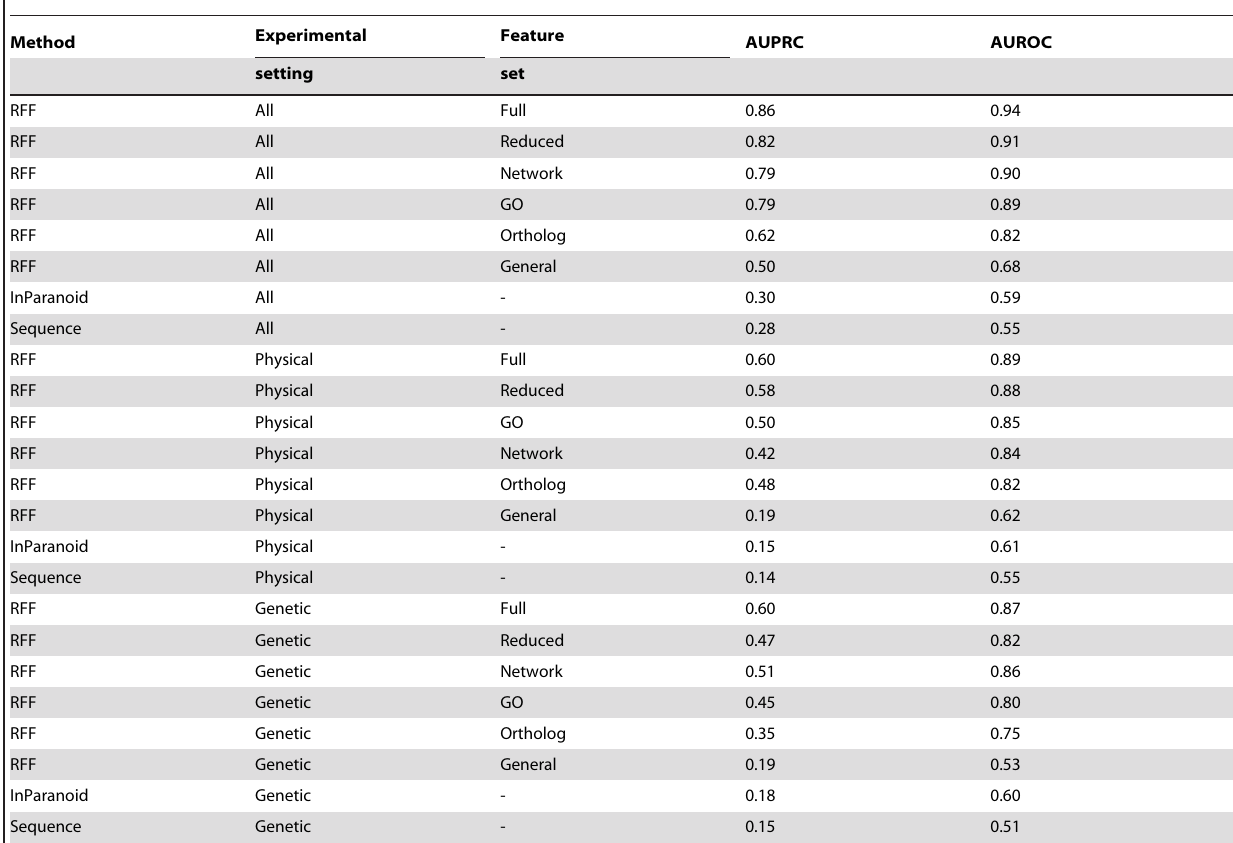
Table 3. Result details for the transfer to S. cerevisiae.